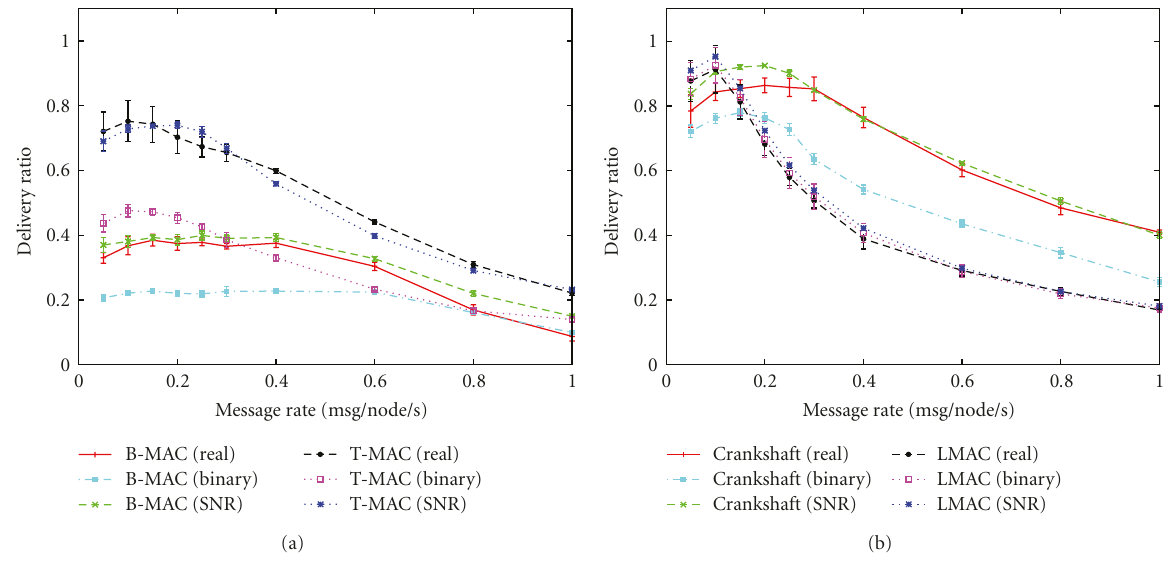
Figure 2: Delivery ratio for simulated and real convergecast experiments.